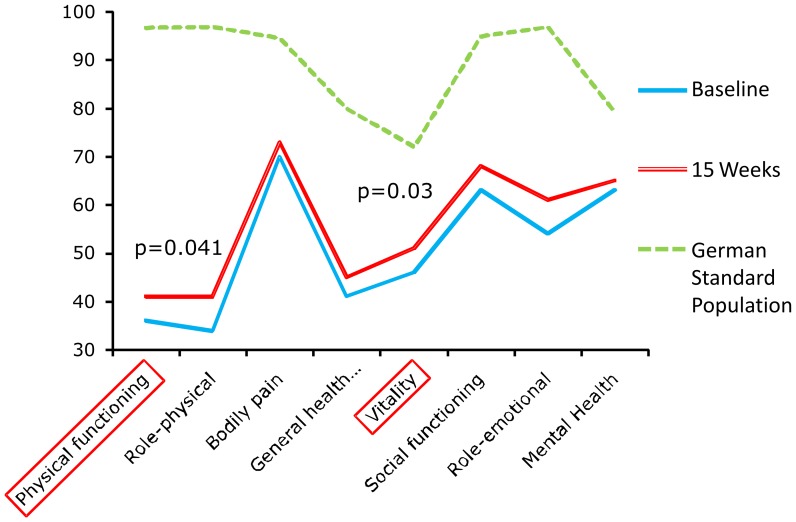
Mean SF-36 scores of Quality of life Subscales (SF-36 questionnaire) before and after Exercise Training.At baseline (straight line), mean SF-36 scores were significantly reduced in comparison to respective values of a normal population (dotted line). After 15 weeks (dashed line), the 2 subscales of the SF-36 questionnaire physical functioning and vitality improved significantly. P-values are indicated vs. baseline. No significant improvement was found for role emotional (ROLEM), role physical (ROLPH), general health (GH), social functioning (SF), mental health (MH), bodily pain (PAIN) after training. With Bonferroni adjustment, values of p<0.005 preserve statistical significance. At baseline data of 28 patients, after 15 weeks of 23 patients were available and included.